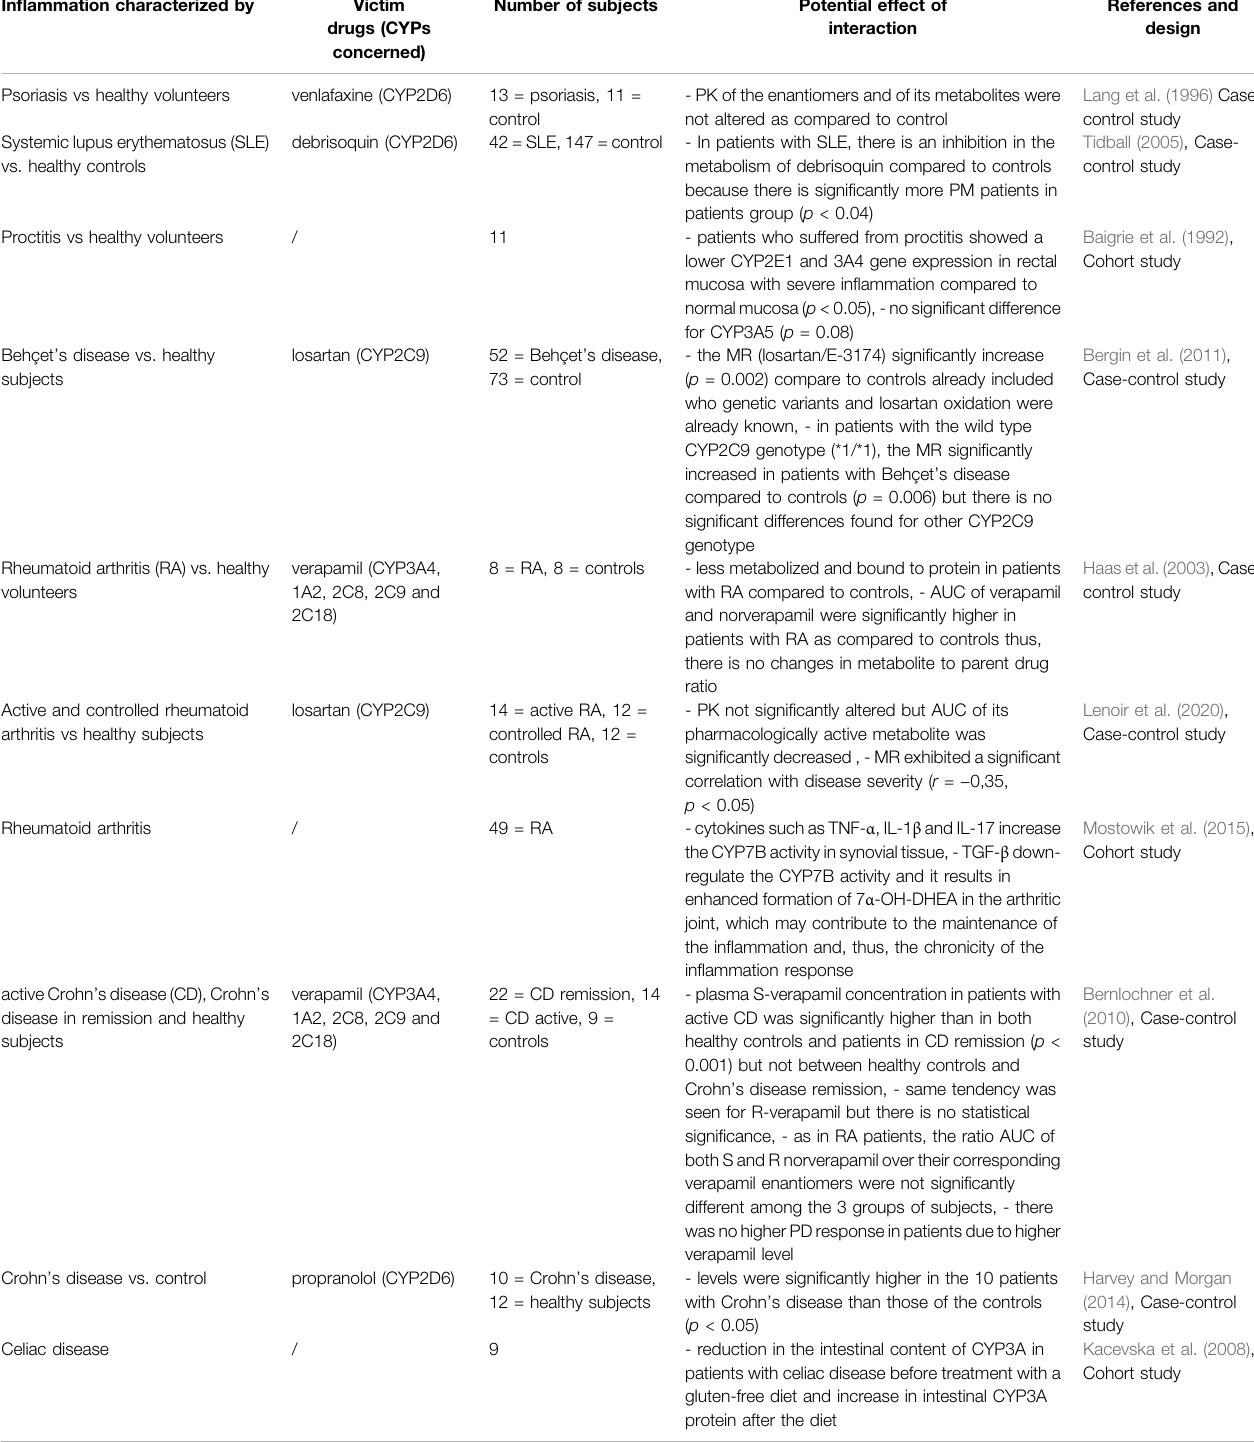
TABLE 10 | Impact of autoimmune diseases on CYP substrates, explained totally or partially by modulation of CYP activity. In fl ammation characterized